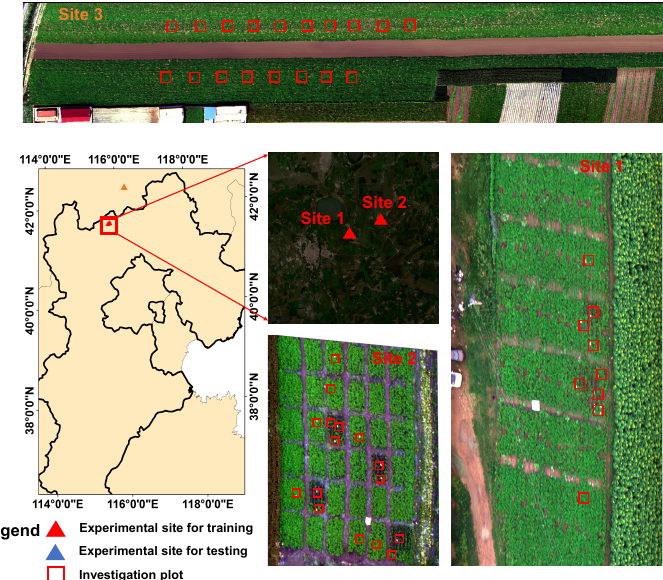
Figure 1. The experimental sites in Guyuan, Hebei province,